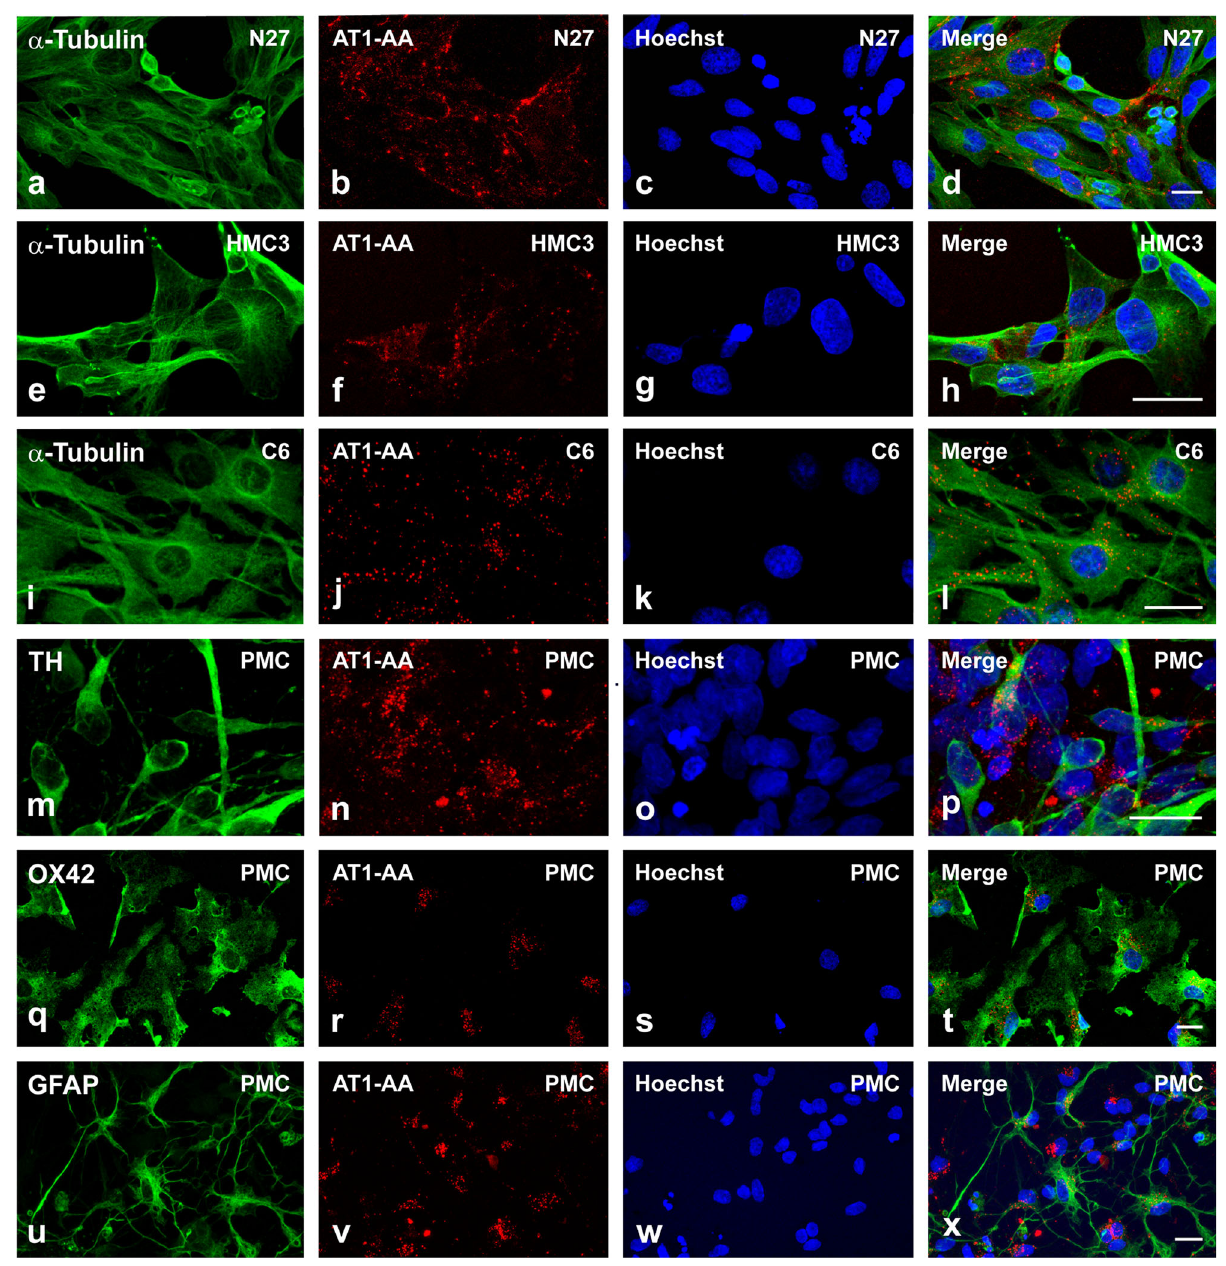
Fig. 4 Dopaminergic neurons, astrocytes and microglia bearing fl uorescent AT1-AA. Triple fl uorescent labelling for (green) the cell marker anti- α -tubulin ( a, e, i ), the dopaminergic neuron marker Tyrosine hydroxylase (TH; m ), the microglial marker CD11b (OX42; q ), the astroglial marker GFAP( u ), and the nuclear marker Hoechst 33342 (blue), and AT1-AA (red dots) in cell lines of dopaminergic neurons (N27; a – d ), microglia (HMC3; e – h ), astroglia (C6; i – l ), and primary mesencephalic cultures (PMC; m – x ) containing dopaminergic neurons ( m – p ), microglia ( q – t ) and astrocytes ( u – x ). Labelling for AT1-AA (red dots) is observed at the cell surface, with practically no colocalization (yellow) with the cytoplasmatic markers. Scale bars: 15